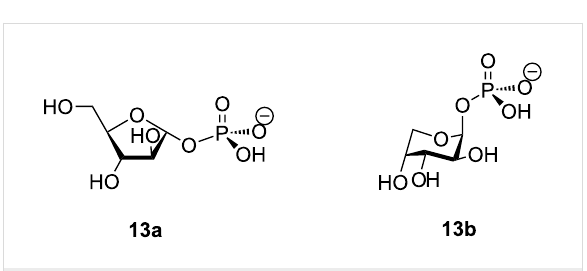
Figure 2: The structures of 1-phosphates of α -D-arabinofuranose ( 13a ; Ara Fur -1P) and β -D-arabinopyranose ( 13b ; Ara Pyr -1P).